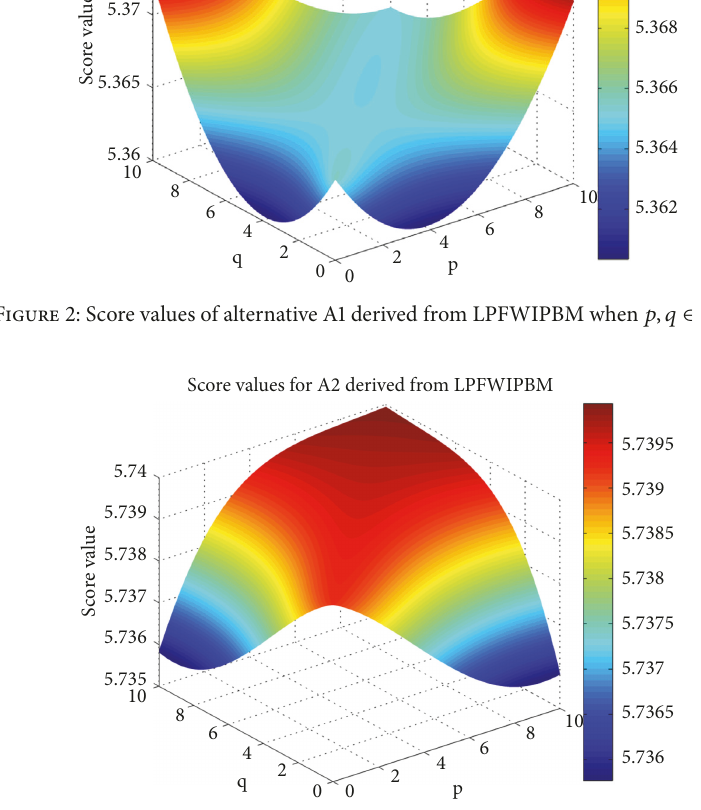
Figure 3: Score values of alternative A2 derived from LPFWIPBM when 𝑝, 𝑞 ∈ (0,10)